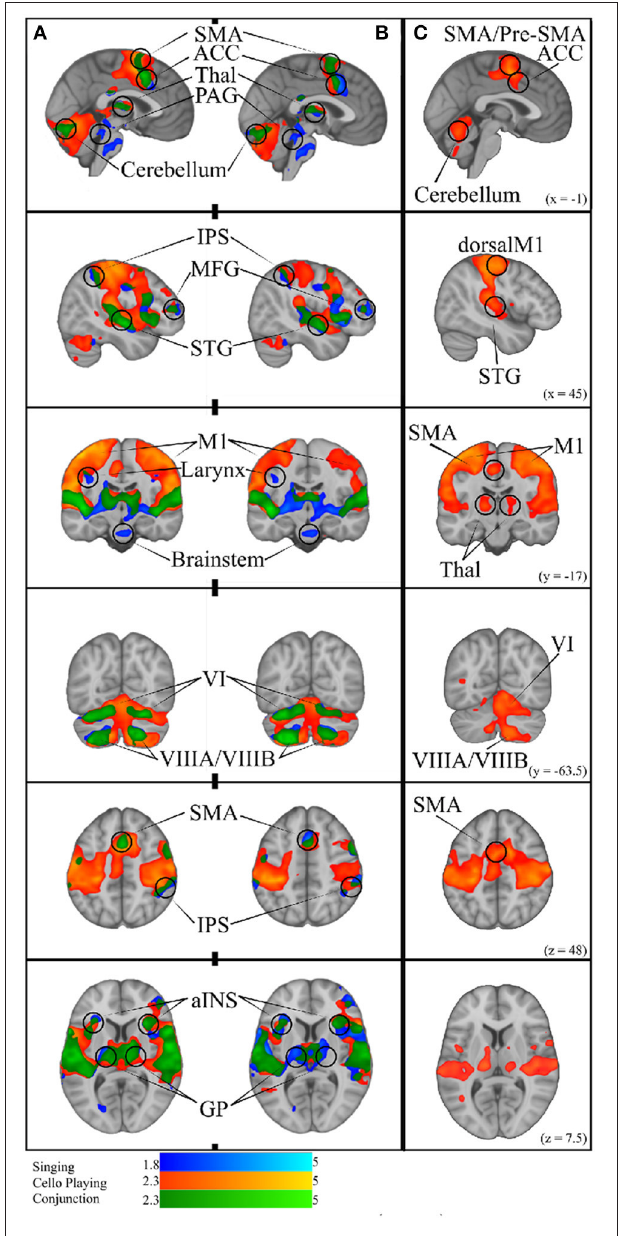
FIGURE 9 | (A) Simple Singing (blue), cello playing (orange), and conjunction (green). (B) Simple singing (blue), cello playing (orange) and conjunction (green) regressed by task accuracy with better performance correlated with more activation. The conjunction of singing and cello playing shows overlapping activation in SMA, ACC, Thalamus, PAG, IPS, MFG, STG, MI (larynx area for singing), aINS, GP, and VI, and VIIIA/VIIIB of the cerebellum. All of these regions were positively correlated with better intonation. (C) Cello playing > Singing throughout dorsal motor and premotor regions, SMA/Pre-SMA., posterior STG, Thalamus, and